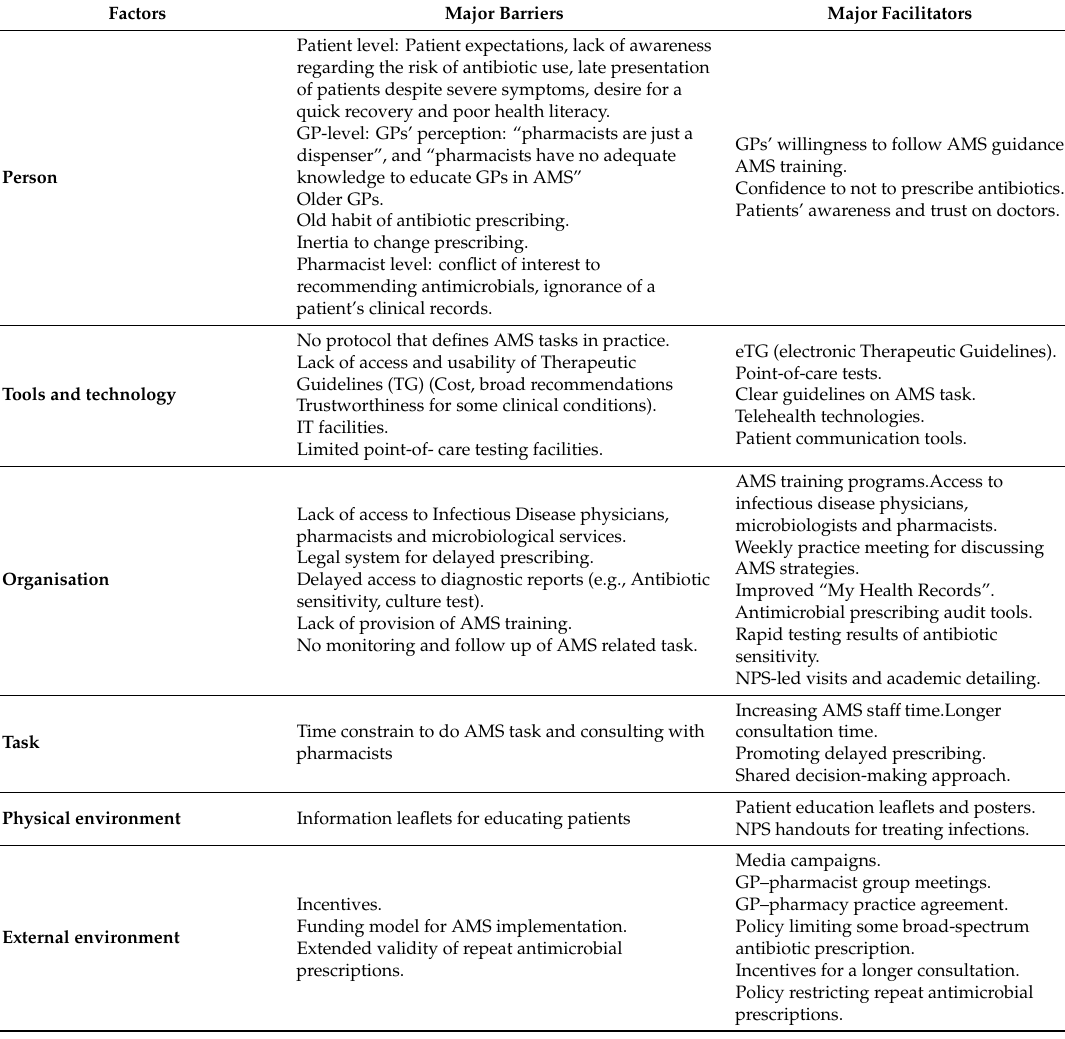
Table 2. Major barriers and facilitators to improving AMS by Australian